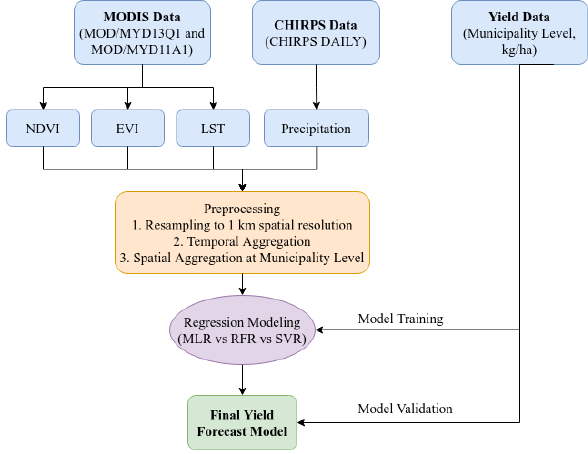
Figure 2. Overall analysis